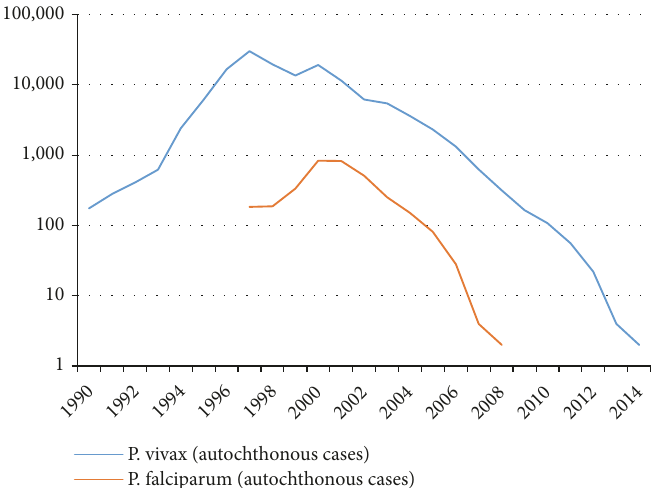
Figure 1: Numbers of malaria cases in Tajikistan, 1990-2014. Source: Republican Tropical Diseases Center, Ministry of Health, Tajikistan.